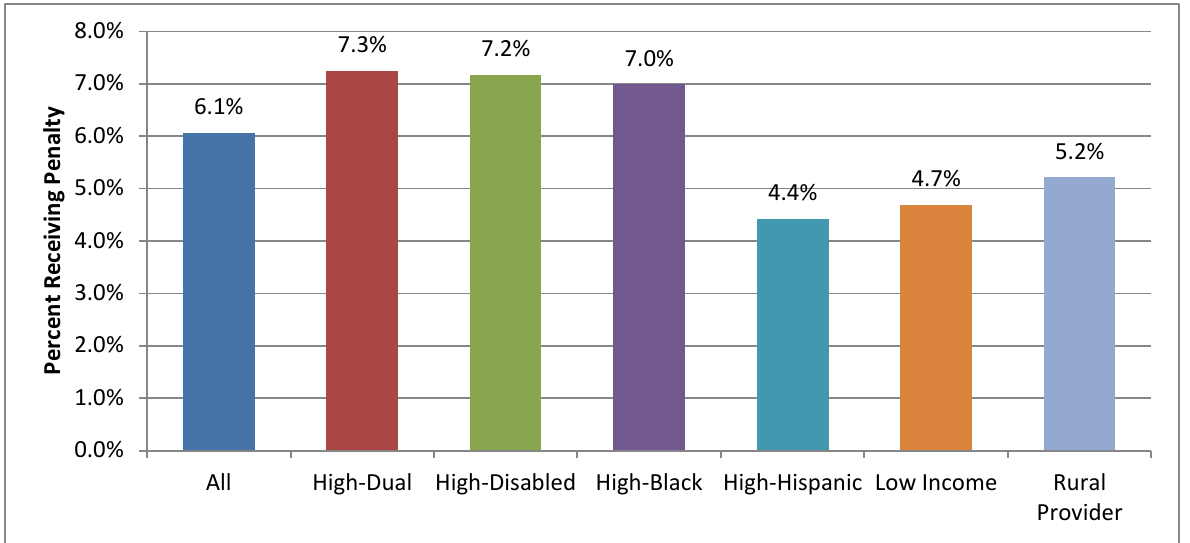
Figure 11.4: Likelihood of Penalties by Facility Type